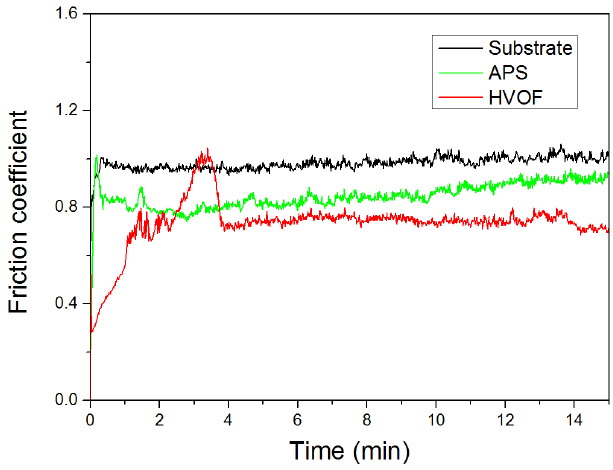
Figure 8. The friction coefficients of the APS coating, the HVOF coating, and the 45# steel substrate.